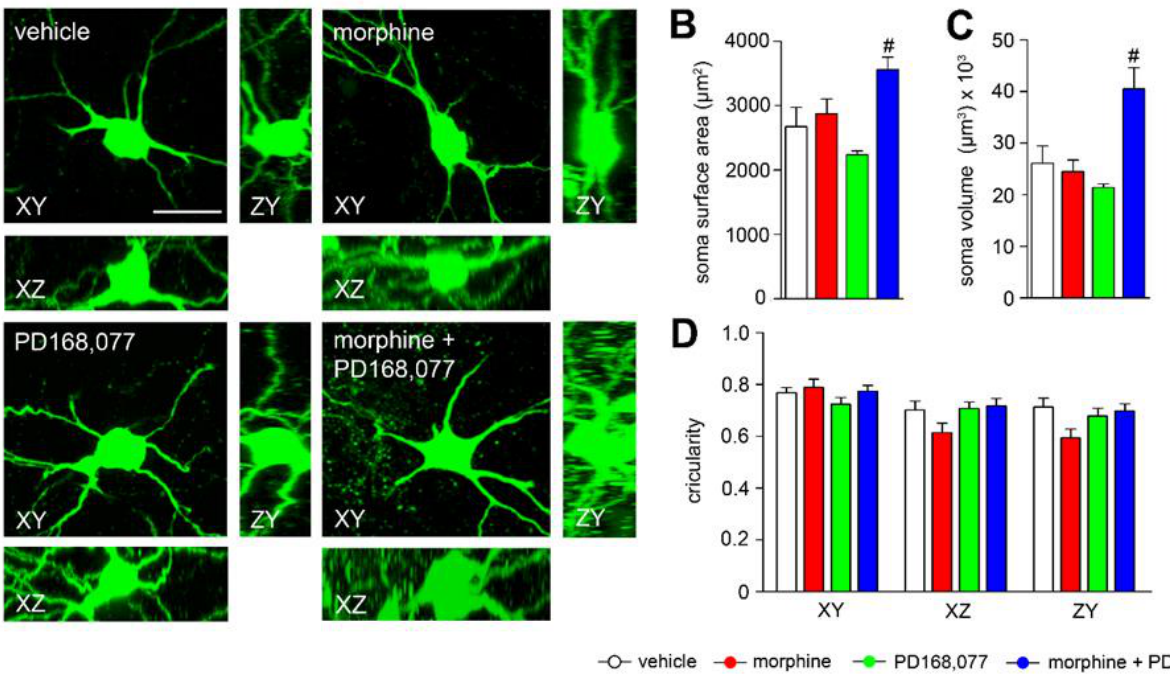
Figure 3. Co-treatment with the D4R agonist and morphine increases the size of the striatal MSNs. ( A ) Representative XY, XZ and YZ confocal images of MSNs soma showing the effect of continuous treatment (14 days) with vehicle, morphine (20 mg/kg/d), PD168,077 (1 mg/kg/d) and morphine + PD168,077 (20 mg/kg/d and 1 mg/kg/d). ( B , C ) Histograms represent the effect of drugs treatment on surface area (μm2) and volume (μm3) of the striatal MSNs. ( D ) Graph depicts the circu- larity (index for soma shape) of MSNs evaluated in the three axis (XY, XZ and XY). Data represents mean ± SEM, n = 23 neurons on average per treatment. One-way ANOVA followed by Tukey test, # p < 0.05 vehicle vs. morphine + PD168,077. Scale bar is 30